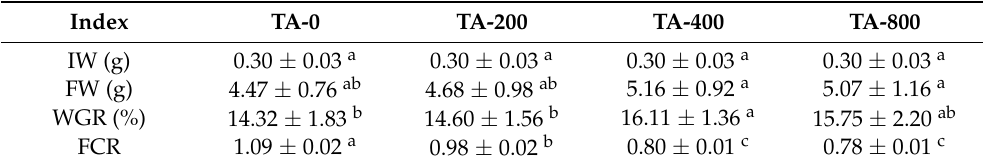
Table 2. Growth performance and feed utilization of L. vannamei that were fed the control and TA diets for 56 days.